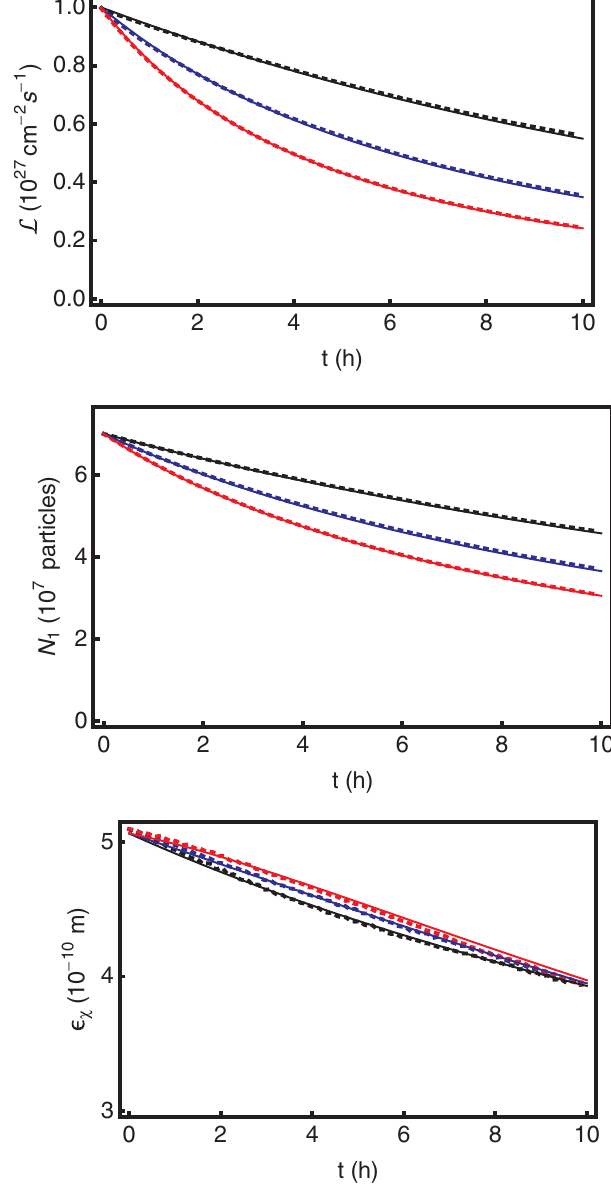
FIG. 11. (Color) The simulated time evolution in the LHC of the luminosity, bunch intensity, and transverse rms emittance during a 10 h store at top energy with colliding beams. Results are shown from the tracking method (dotted lines) and the ODE method (solid lines) for the cases of one (black lines), two (blue lines), or three (red lines) active IPs taking